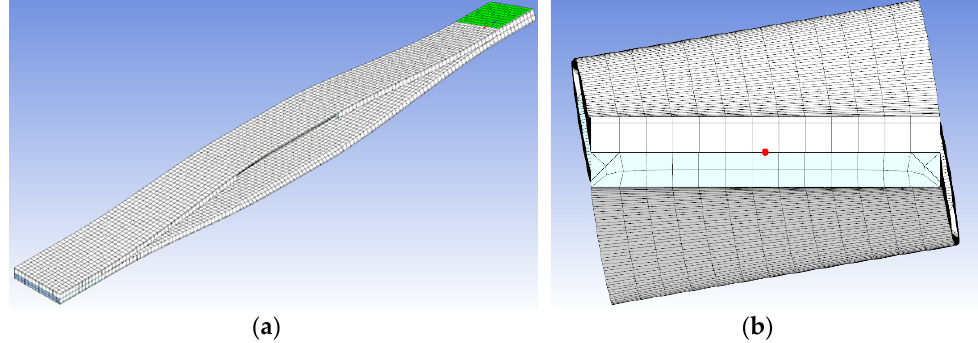
Figure 4. ( a ): test set expanded by 30 mm. ( b ): test set expanded by 30 mm and twisted by 20°.